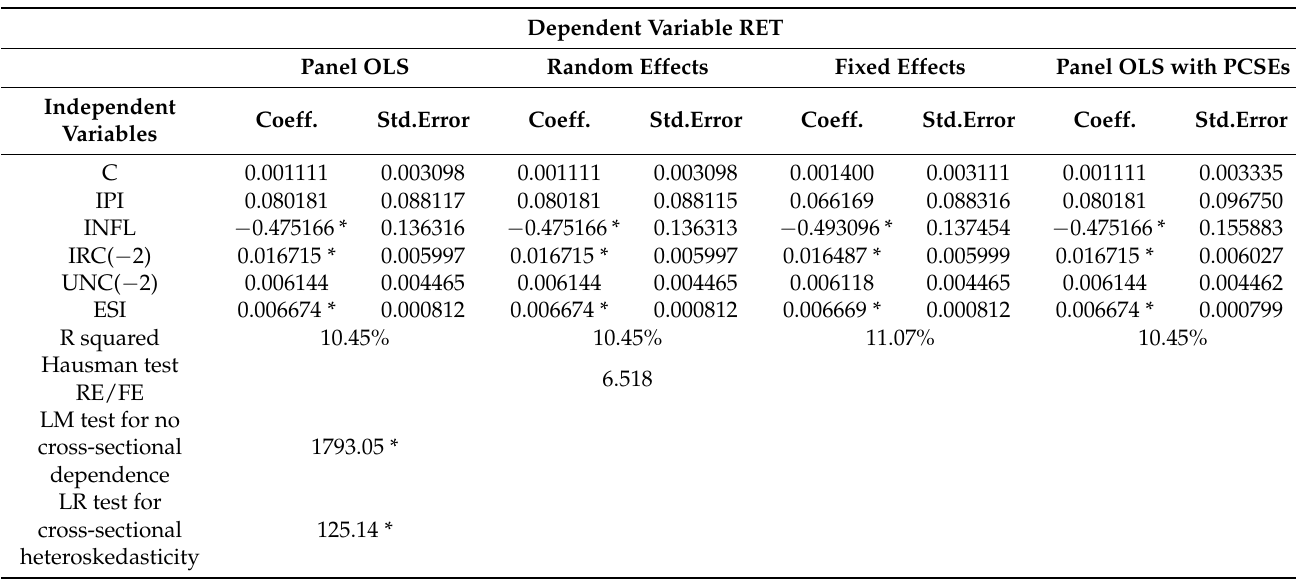
Table 3. Results for full sample of eight countries.